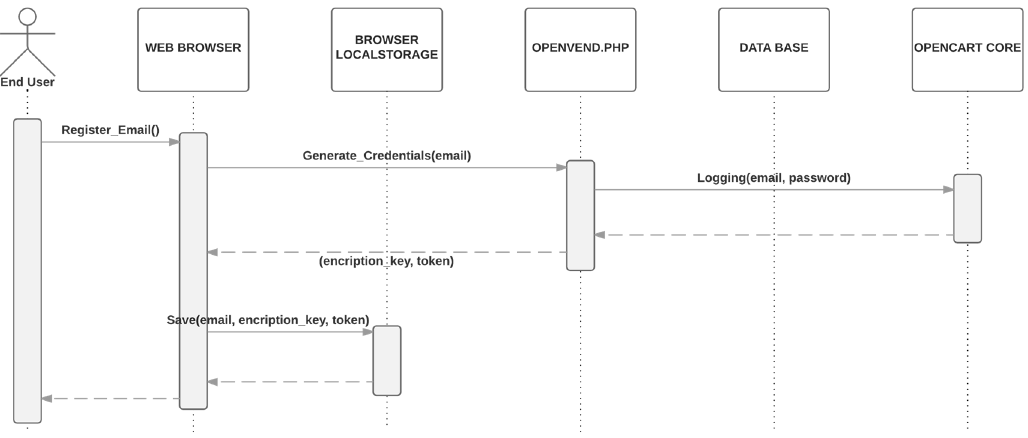
Figure 5. Registration process with end-user email and one-time token.